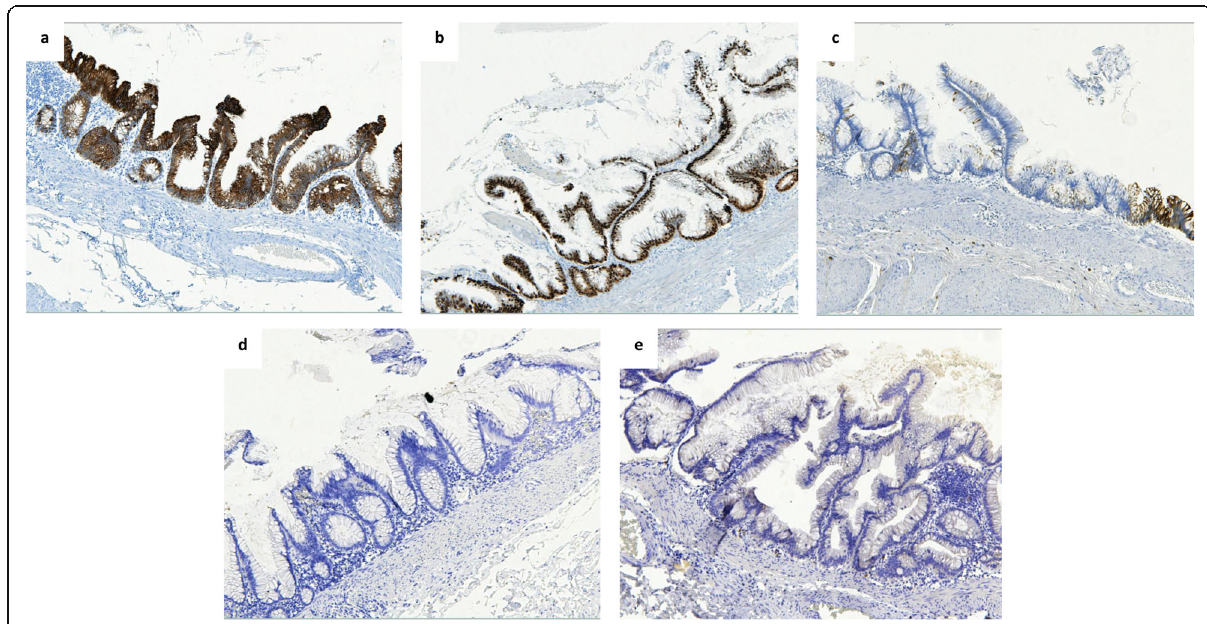
Fig. 2 Immunohistochemical profile of the colonic epithelium with LAMN inside the ovarian teratoma. The epithelial cells are strongly stained by